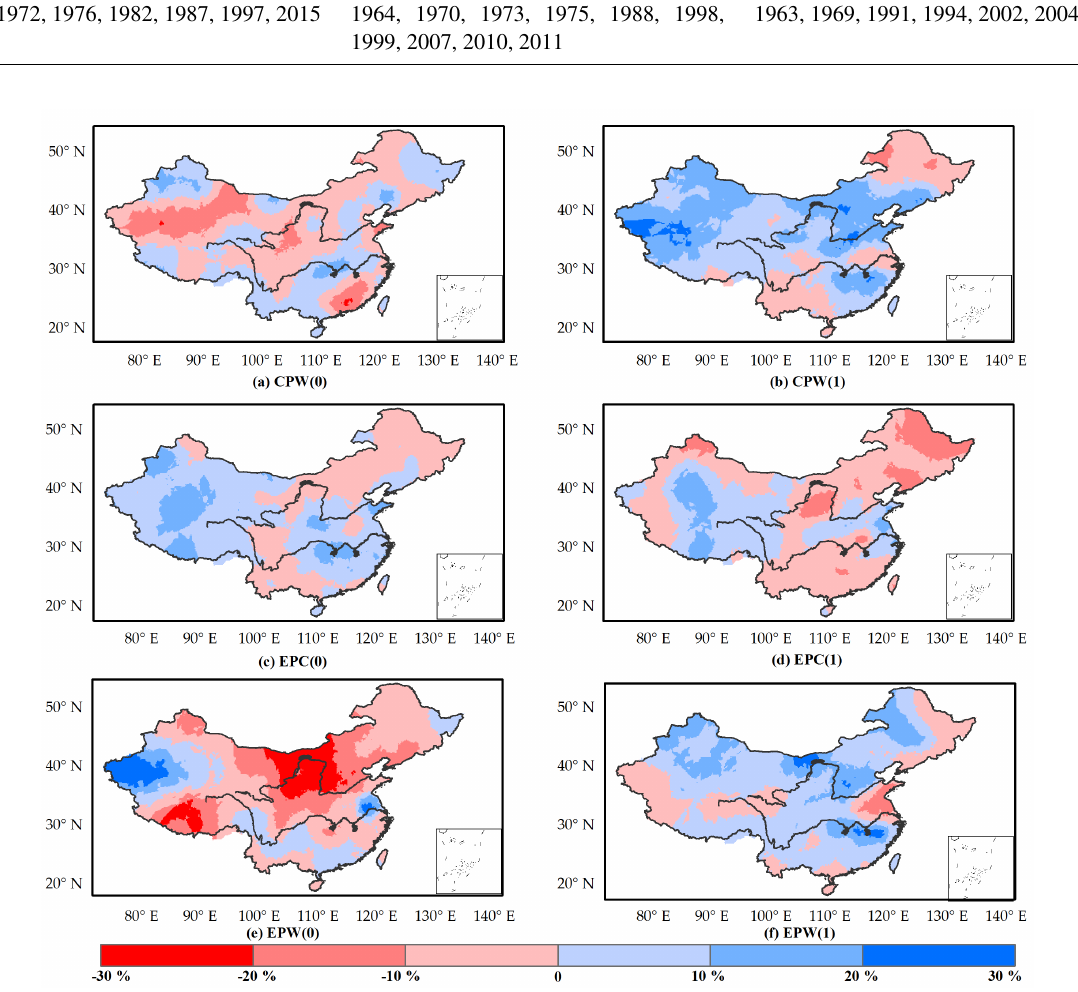
Figure 2. Spatial pattern for rainy-season precipitation anomaly (PARS) during the CPW (first row), EPC (second row) and EPW (third row) episodes in the phase of ENSO developing year (0) and decaying year (1). The sign “0” in the parentheses denotes ENSO developing year and “1” denotes decaying